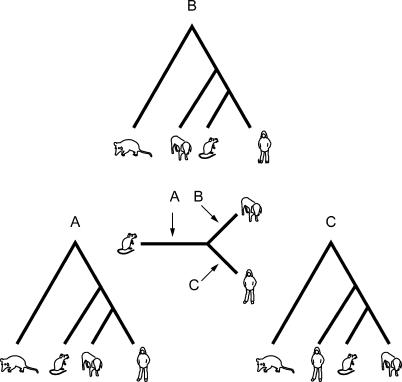
Rooted and Unrooted TopologiesUnrooted trees of three species (human, dog, mouse) display no information about the speciation order (center triplet). Only the use of an outgroup (opossum) places the root on one of the three branches (labeled A, B, and C), giving three possible rooted trees corresponding to the three hypotheses being tested.